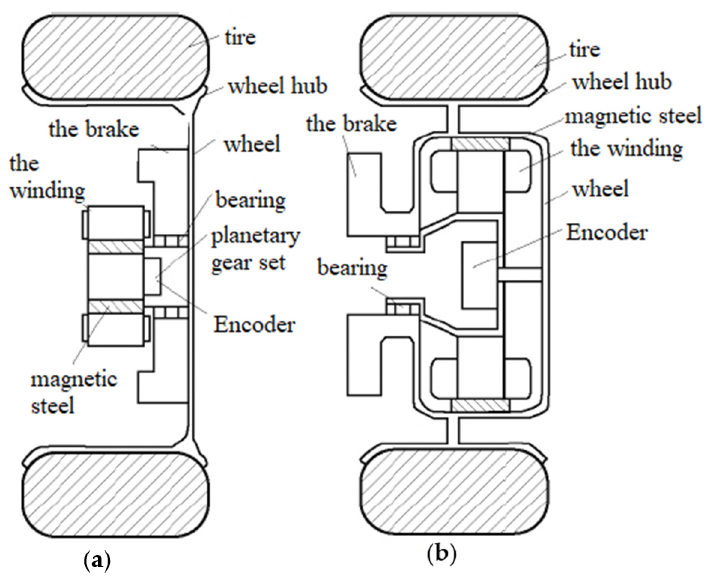
Figure 3. Schematic diagram of in-wheel motor structure ( a ) Deceleration drive ( b ) Direct drive.